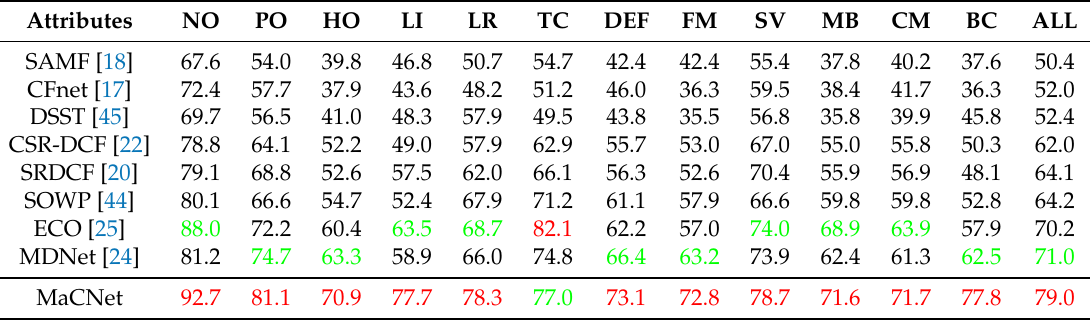
Table 5. Attribute-based PR scores (%) on RGBT234 dataset [13] against with eight RGB trackers. Optimal and suboptimal results are represented by red and green fonts,